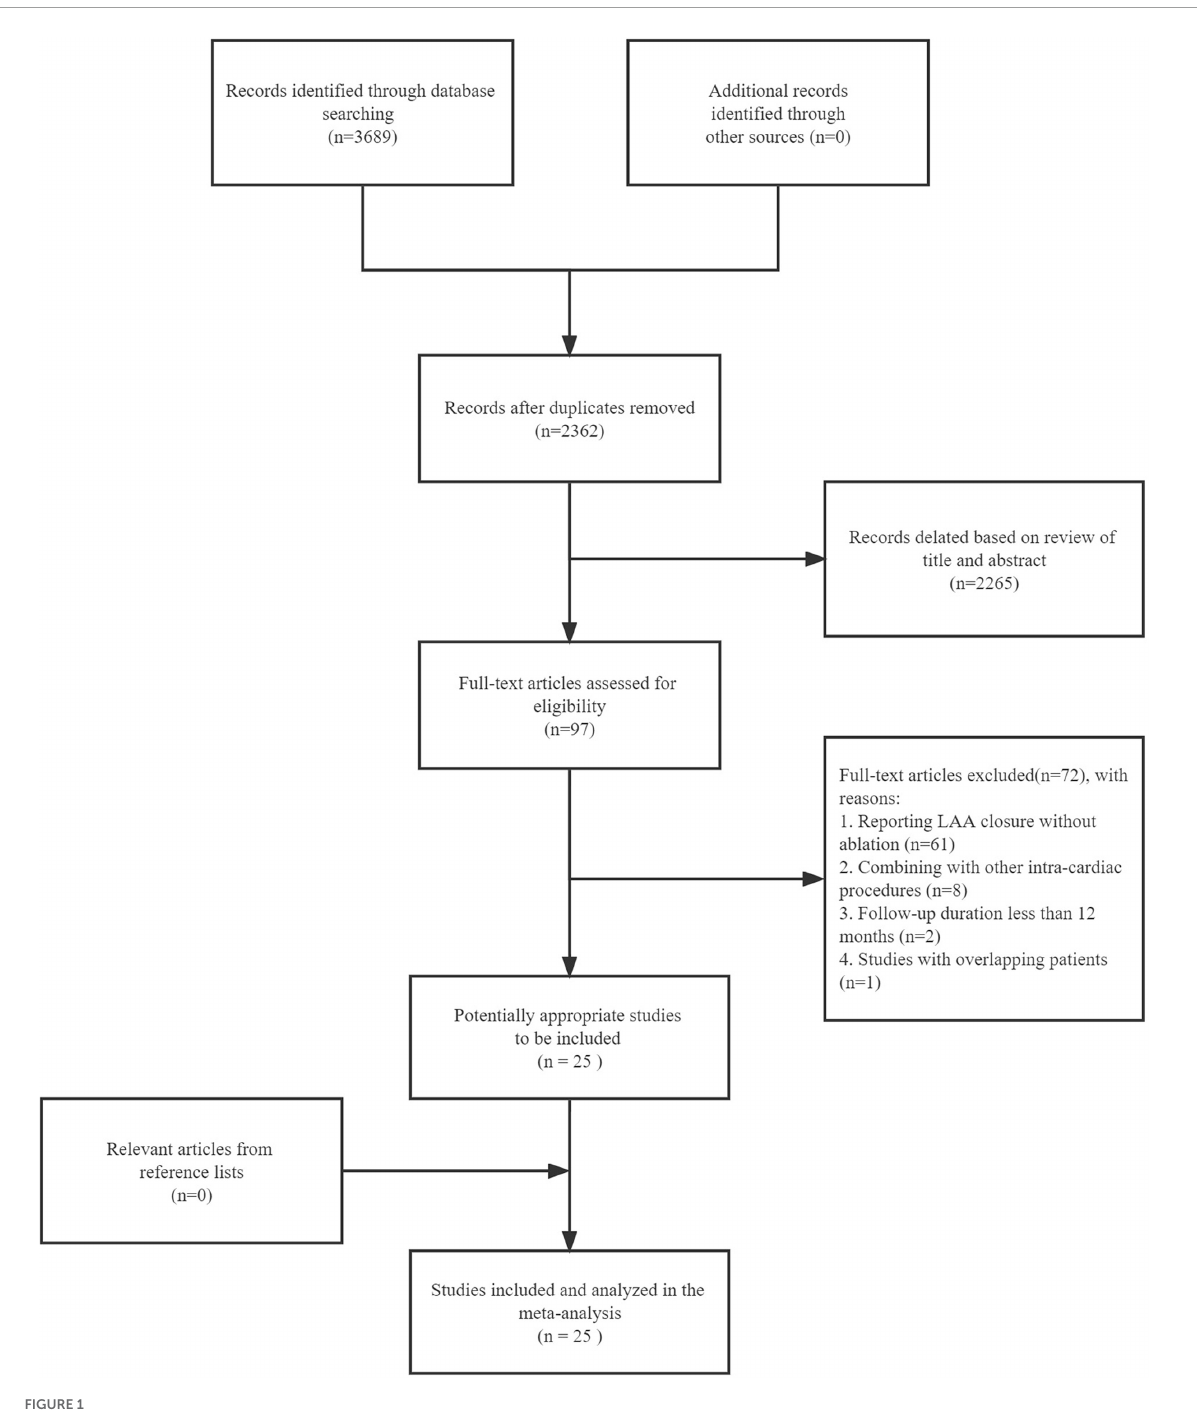
72 studies were omitted for not satisfying the eligibility criteria (61 for reporting LAA closure without ablation; 8 for combining with other intra-cardiac procedures; 2 for follow-up duration less than 12 months; 1 study for reporting duplicate data). Two